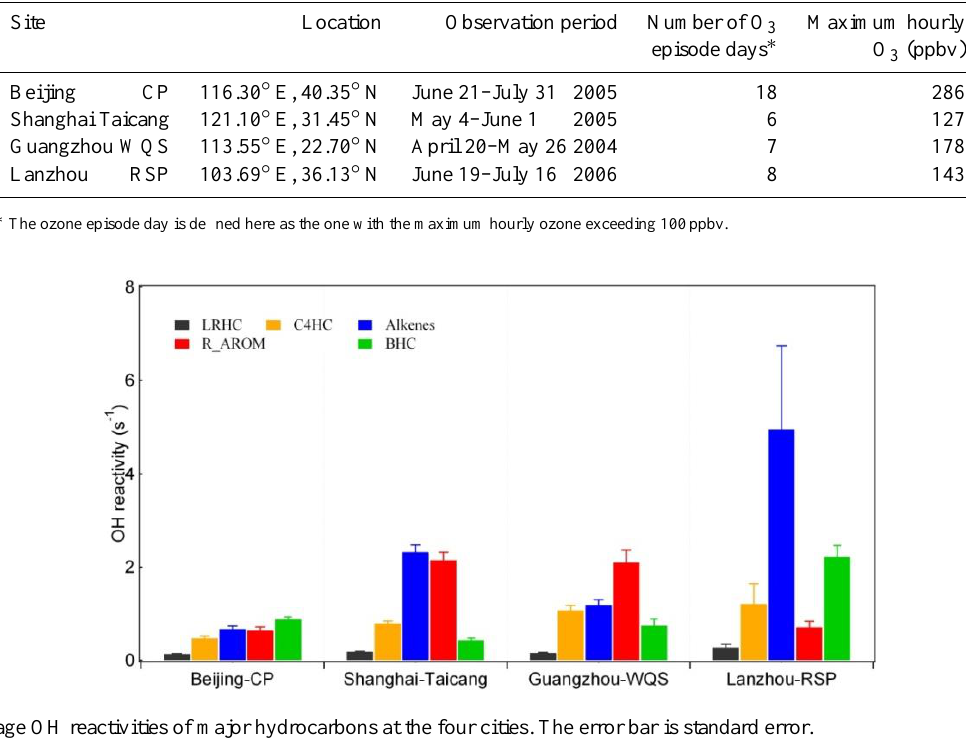
O 3 precursors and imply different O 3 formation regimes